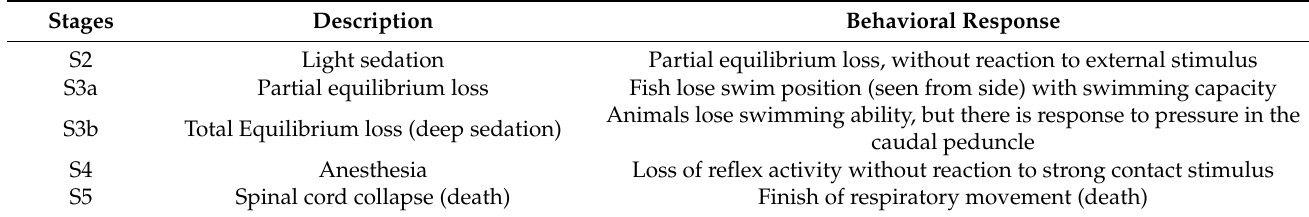
Table 6. Fish sedation and anesthesia